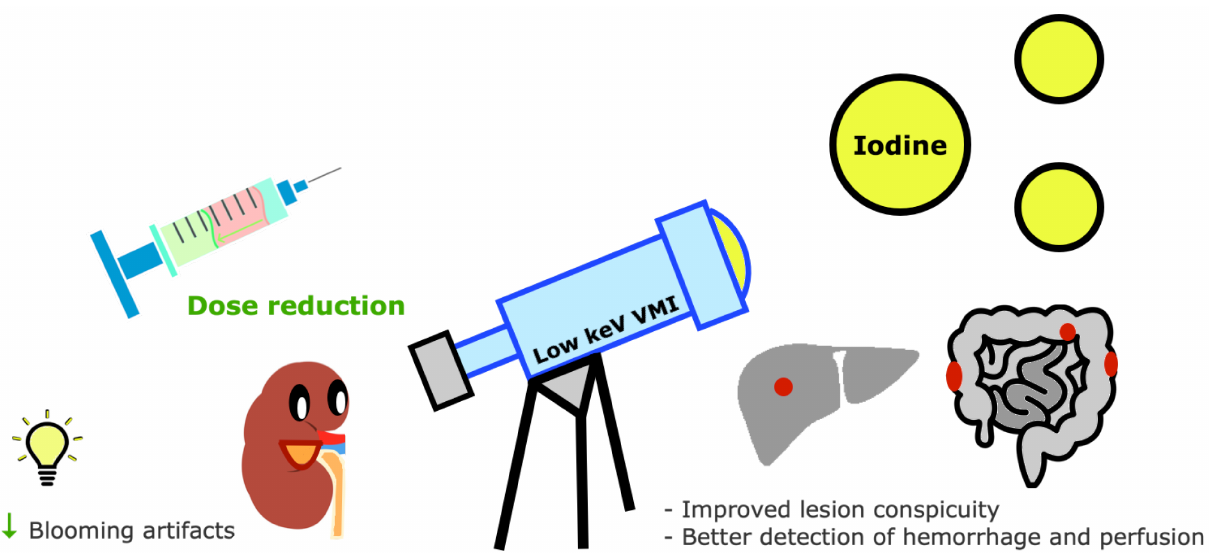
Figure 13. Contrast enhancement improvement with DECT imaging. Iodine density is amplified on low-keV virtual monochromatic images (VMIs). The improved sensitivity for iodine with DECT allows a reduction of iodine dose, which is useful in patients with compromised renal function and reduces blooming artifacts. Other advantages include improved lesion conspicuity and better detection of hemorrhage and perfusion